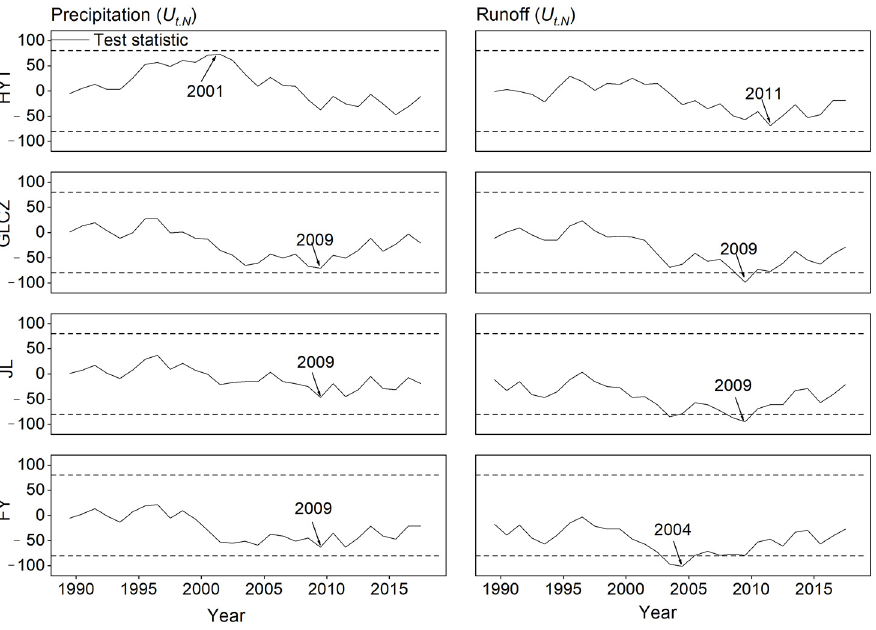
Figure 3. Results of Pettitt breakpoint test of the SSR basin.